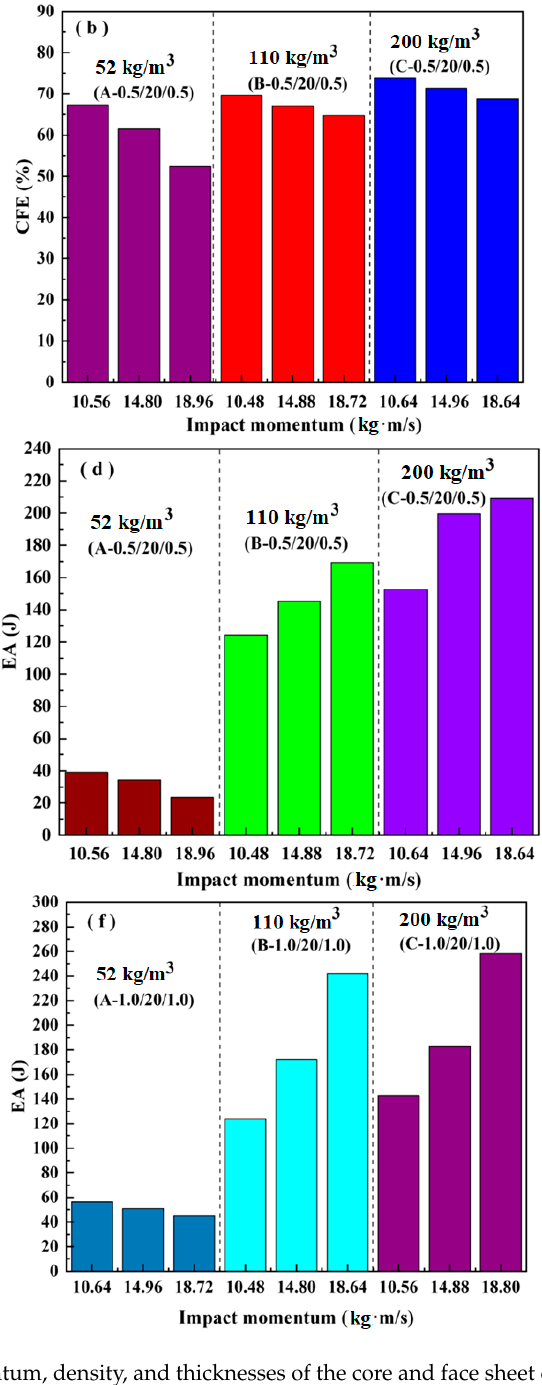
Figure 11. Effects of the impact momentum, density, and thicknesses of the core and face sheet on the crush force efficiency of: ( a ) (0.5/10/0.5); ( b ) (0.5/20/0.5); and energy absorption of: ( c ) (0.5/10/0.5); ( d ) (0.5/20/0.5); ( e ) (1.0/10/1.0); ( f ) (1.0/20/1.0).